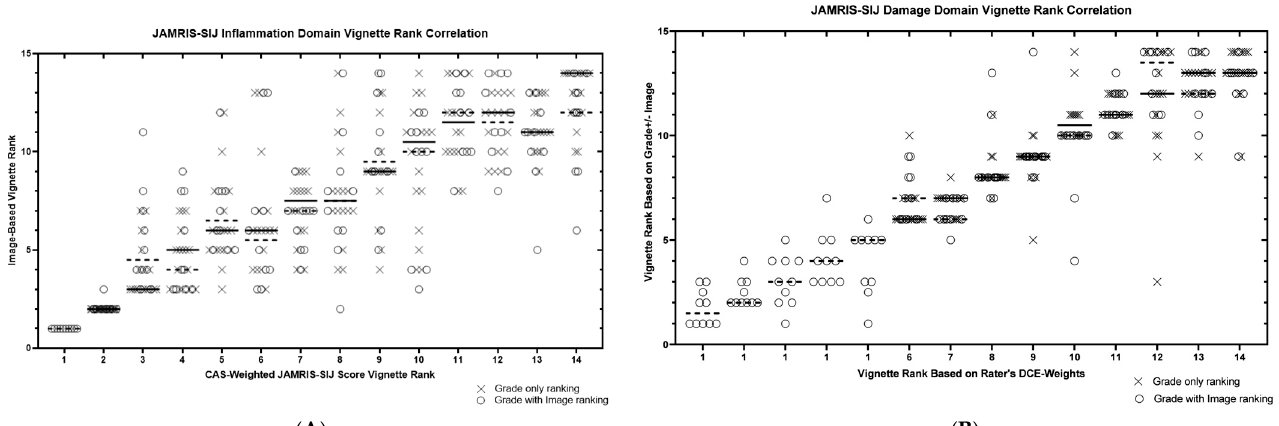
Figure 2. ( A , B ) Scatter plot of the of the JAMRIS-SIJ vignette ranks. ( A ) Scatter plot of the JAMRIS-SIJ vignette ranks produced by the full profile, MR image + grade ranking, ordered by consensus-graded, weighted JAMRIS-SIJ grade-only vignettes for the inflammation domain. Twelve imaging experts participated in the JAMRIS-SIJ image + grade ranking (circle maker), and 16 experts in the grade-only ranking (cross maker). For each of the 14 vignettes received, a consensus weighted grade rank on the x-axis and y-axis values for the image + grade ranks provided by the individual experts. Horizontal line denotes the median weighted score rank provided to each of the JAMRIS-SIJ MR image + grade vigne tt es. ( B ) Sca tt er plot of the of the JAMRIS-SIJ vigne tt e ranks produced by the full pro fi le, MR image + grade ranking, ordered by consensus-graded, weighted JAMRIS-SIJ grade-only vigne tt es for the damage domain. Twelve imaging experts participated in the JAMRIS-SIJ image + grade ranking (circle maker), and 16 experts in the grade-only ranking (cross maker). For each of the 14 vigne tt es received, a consensus weighted grade rank on the x-axis and y-axis values for the image + grade ranks provided by the individual experts. Horizontal line denotes the median weighted score rank provided to each of the JAMRIS-SIJ MR image + grade vigne tt es.